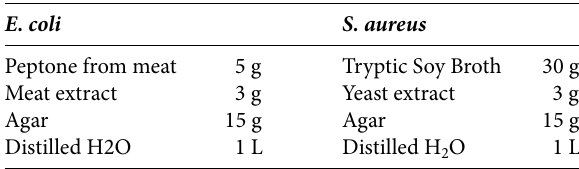
Table 1 . Growth media for E. coli and S. aureus E.